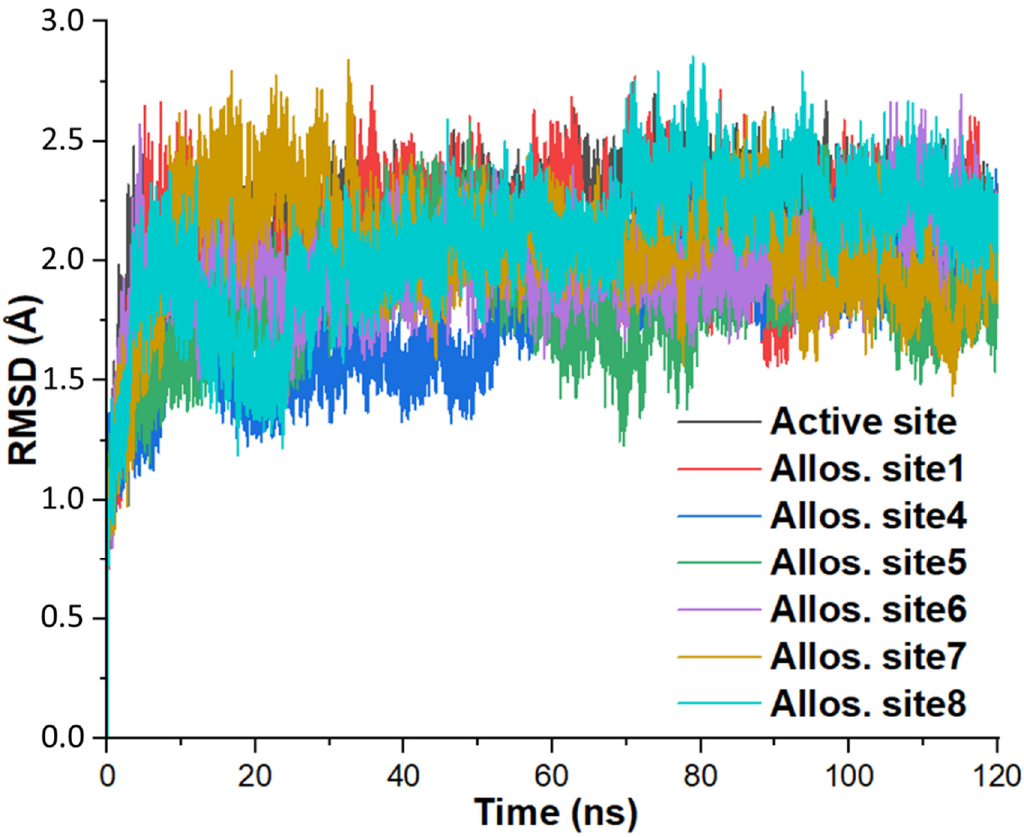
Figure 7. Evolution of the alpha carbon backbone atom root-mean-square deviation (RMSD/angstrom) over 120 ns molecular simulations for compound 1 binding to various regions on BACE1 structure. Allos. site represents the allosteric site and the definition for each site including the interaction residues is available in Figure 6.